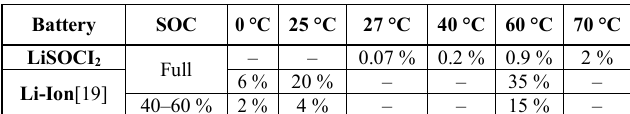
TABLE III S ELF - D ISCHARGE OF L I -I ON AND L I SOCI 2 B